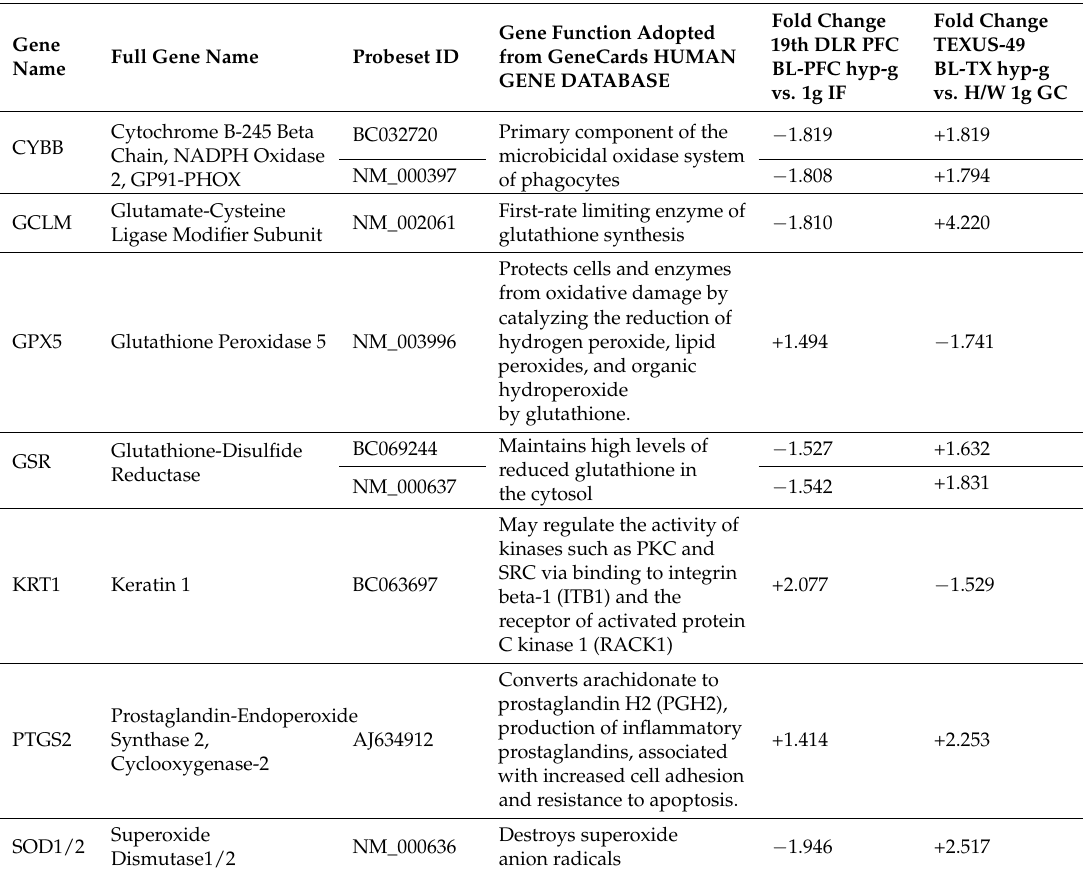
Table 8. Differentially regulated transcripts in hypergravity identified in the 19th DLR parabolic flight and TEXUS-49 suborbital ballistic rocket campaigns. Eight transcripts (belonging to six genes) were reversely regulated with respect to both altered gravity platforms. One transcript (belonging to the gene PTGS2) was significantly up-regulated in both campaigns. Plus: significantly up-regulated transcripts ( p -value < 0.05, fold change (FC) ≥ 1.3), minus: significantly down-regulated transcripts ( p -value < 0.05, FC ≤ − 1.3). FCs are ratios between the averages of linear expression values. If the ratio is <1, FC is calculated as the negative reciprocal of the ratio. Remark: The FCs for BC032720 were − 1.81890805409698 (BL-PFC hyp-g versus 1g IF) and 1.81896050075992 (BL-TX hyp-g versus H/W 1g GC). For the abbreviations of the experiment group names see Table